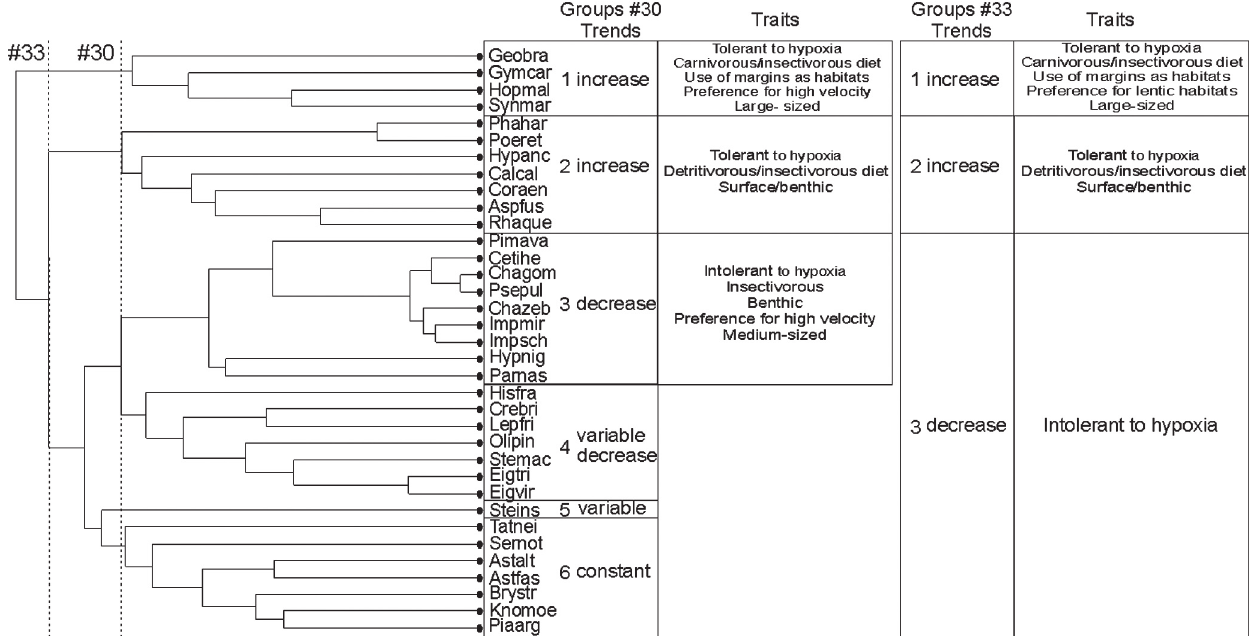
Fig. 3. Identification of the functional groups defined by partitions #30 and #33, with their respective trends of change in species abundance as a function of deforestation. The dominant traits of the functional groups that were important for stream differentiation according to the DPCoA (Fig. 4) are also shown. Species names are abbreviated according to Table